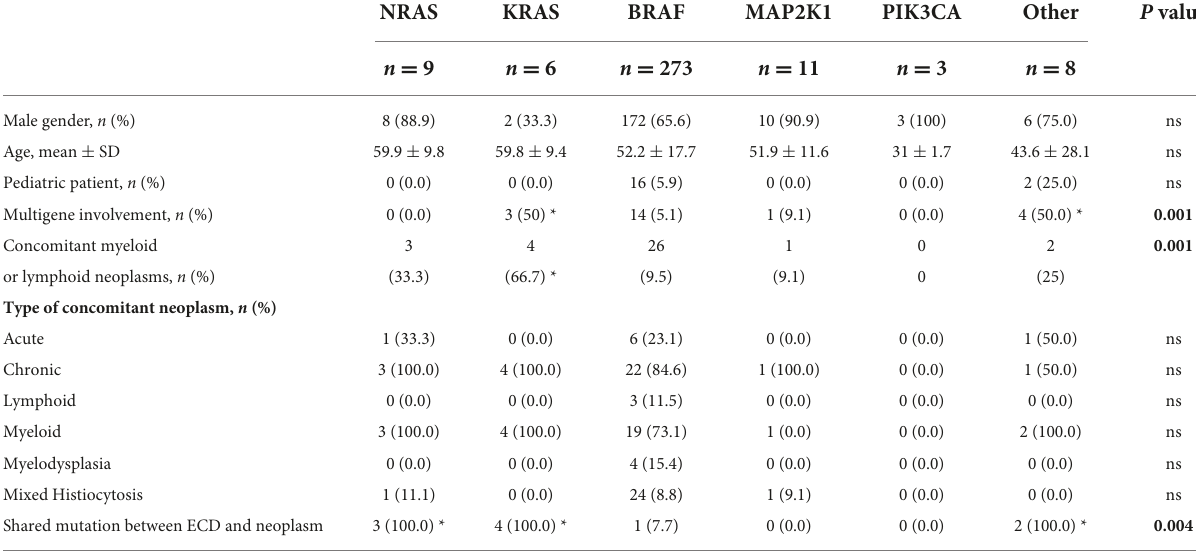
TABLE 1 General characteristics of Erdheim–Chester patients according to different genotypes.